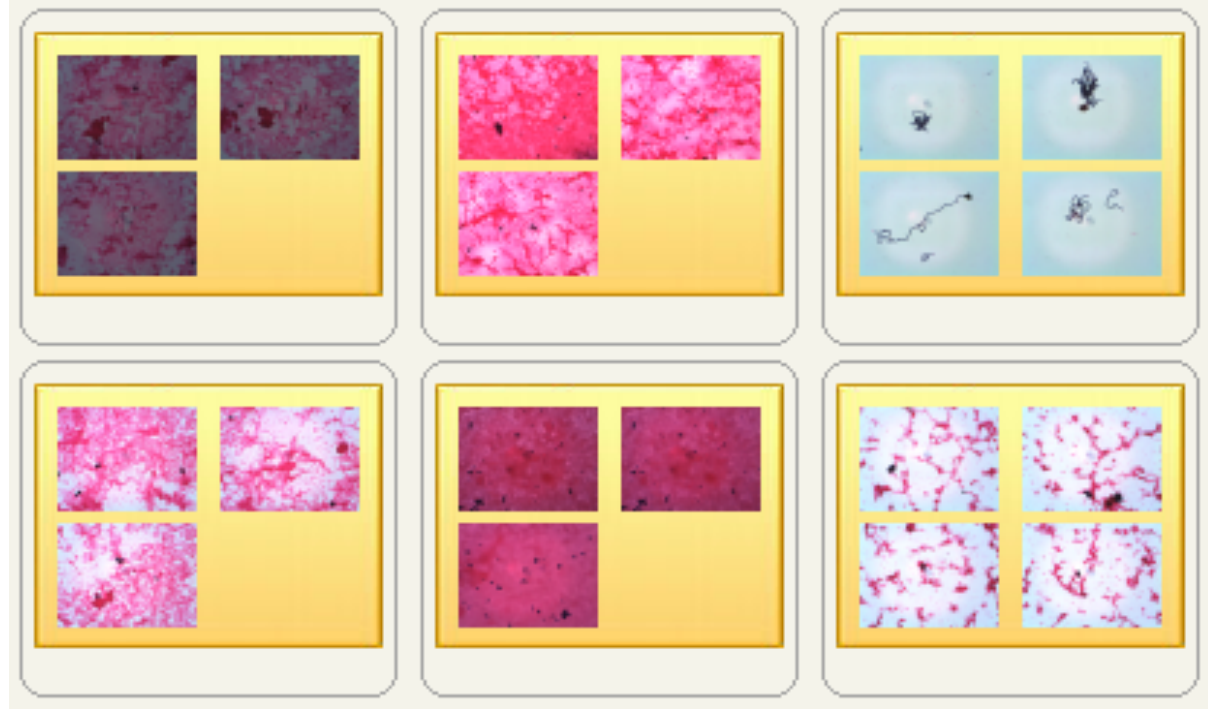
Figure 2. A sample image of Gram stain data. The image label does not have a link to personal